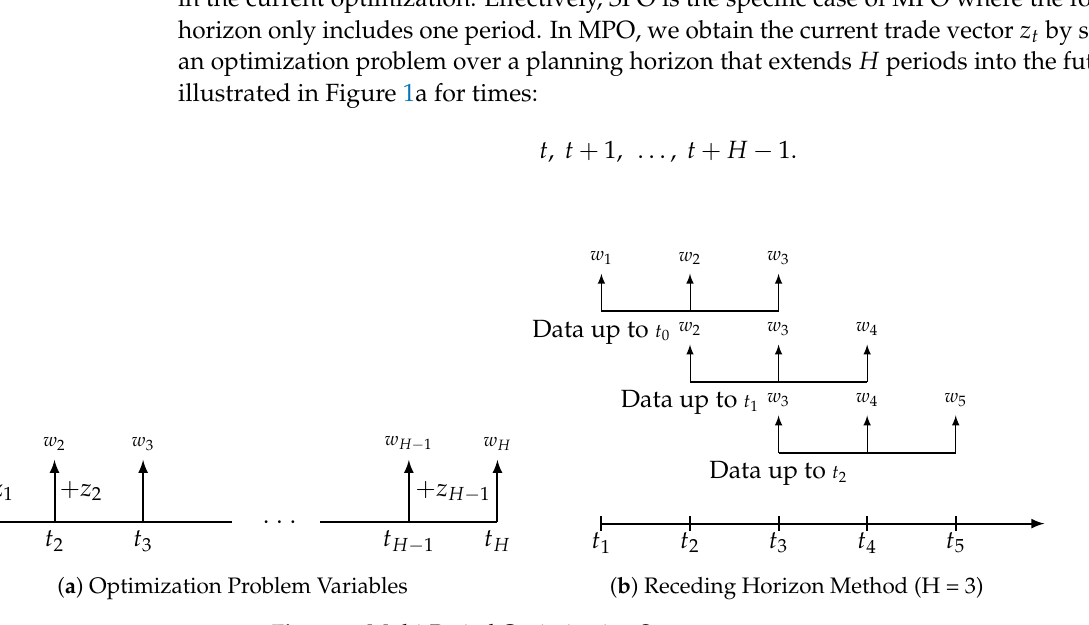
Figure 1. Multi-Period Optimization